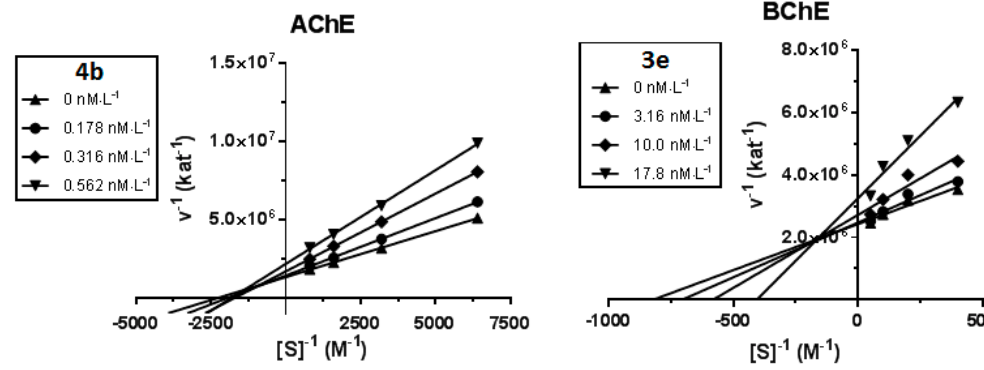
Figure 2. Steady state inhibition of cholinesterase substrate hydrolysis by compound 4b ( h AChE) and 3e ( h BChE) at di ff erent concentrations. Lineweaver − Burk plots of initial velocity at increasing substrate concentrations (AChE: 0.1563–1.250 mM; BChE: 2.5–20.0 mM) are presented. Lines were derived from a linear regression of the data